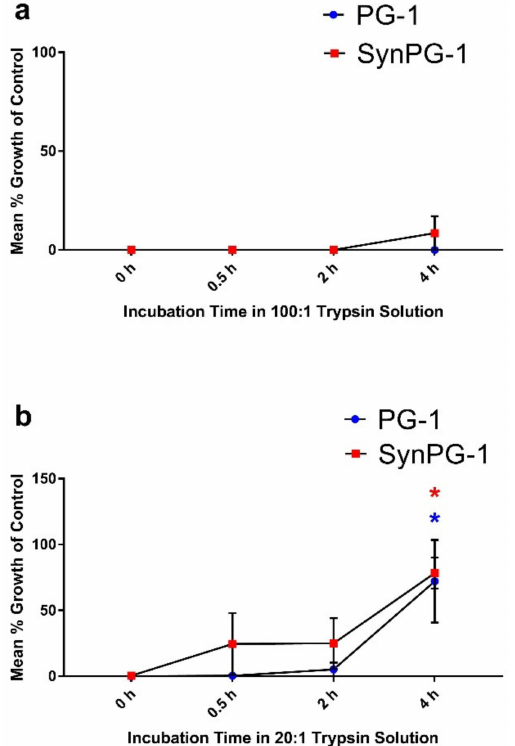
Figure 3. Stability of PG-1 and SynPG-1 against the trypsin enzyme, represented by the mean % bacterial growth of control tested against E. coli ( a ) after peptides were incubated at a ratio of 100:1 (peptide to trypsin) and ( b ) after peptides were incubated at a ratio of 20:1 (peptide to trypsin). Peptides were both tested at a concentration 10 times their MBC (20 µ g / mL). Stability was evaluated by comparing the mean growth of colonies on plates treated with peptides incubated in trypsin to colonies grown when treated without peptide. All experiments were conducted three independent times. Data represent the mean ± SEM of three experiments. The red and blue asterisks represent p < 0.05 in SynPG-1 and PG-1, respectively, when compared to the control by two-way ANOVA with a post hoc Tukey